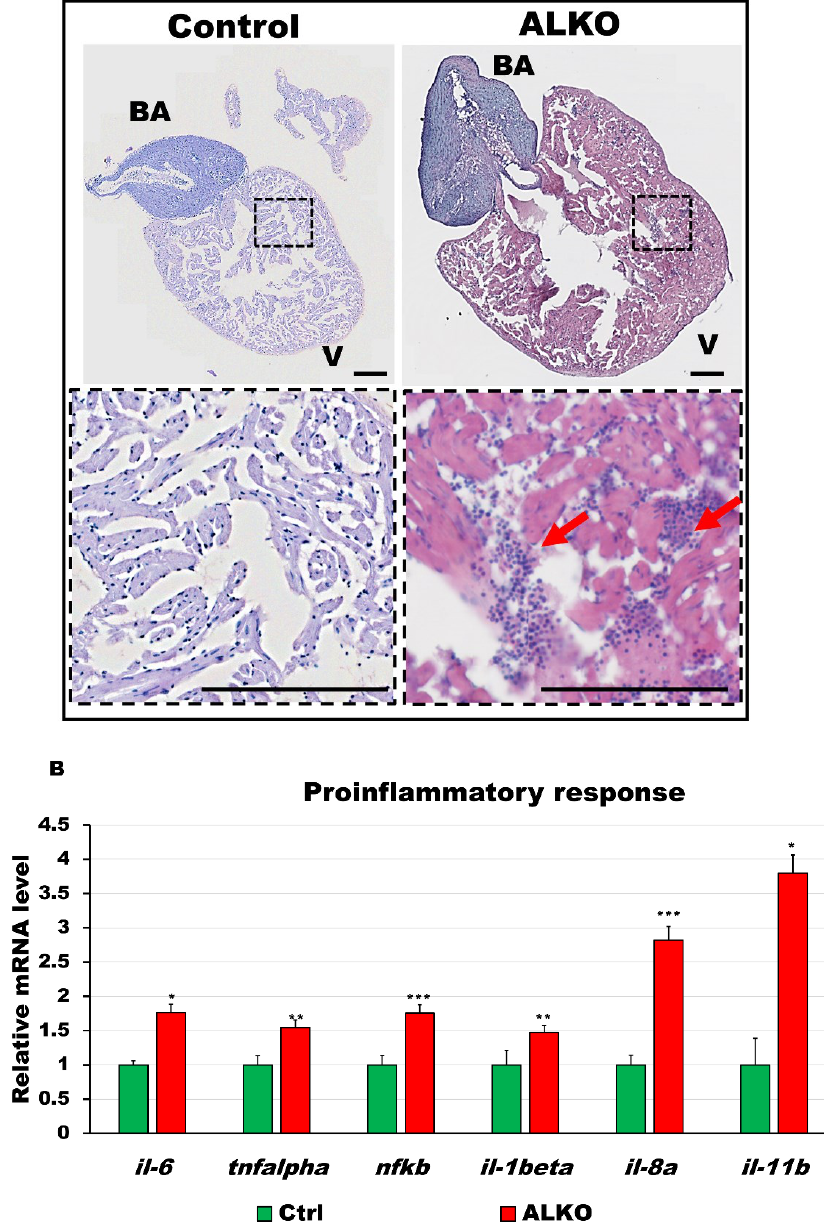
Figure 5. Depletion of Atgl activated immune response in the ventricle of ALKO. ( A ) Hematoxylin and eosin-stained sections of whole hearts of control and ALKO at 5 mpf. Scale bar: 100 μ m. B.A.: bulbus arteriosus, V: ventricle. ( B ) Upregulated proinflammatory markers of ALKO ventricles revealed by RT-qPCR. In the ALKO group, il6 = 1.7615 ± 0.0834, tnfalpha = 1.5474 ± 0.2950, nfkb = 1.7564 ± 0.4665, il-1beta = 1.4744 ± 0.0689, and il-11b = 3.7973 ± 0.7233. Statistically significant differences from the controls are indicated by * p < 0.05, ** p < 0.01, and *** p <